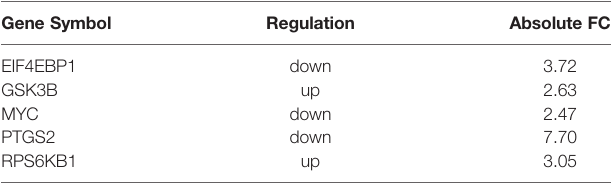
TABLE 1 | Expression of 30 downstream regulatory factors.